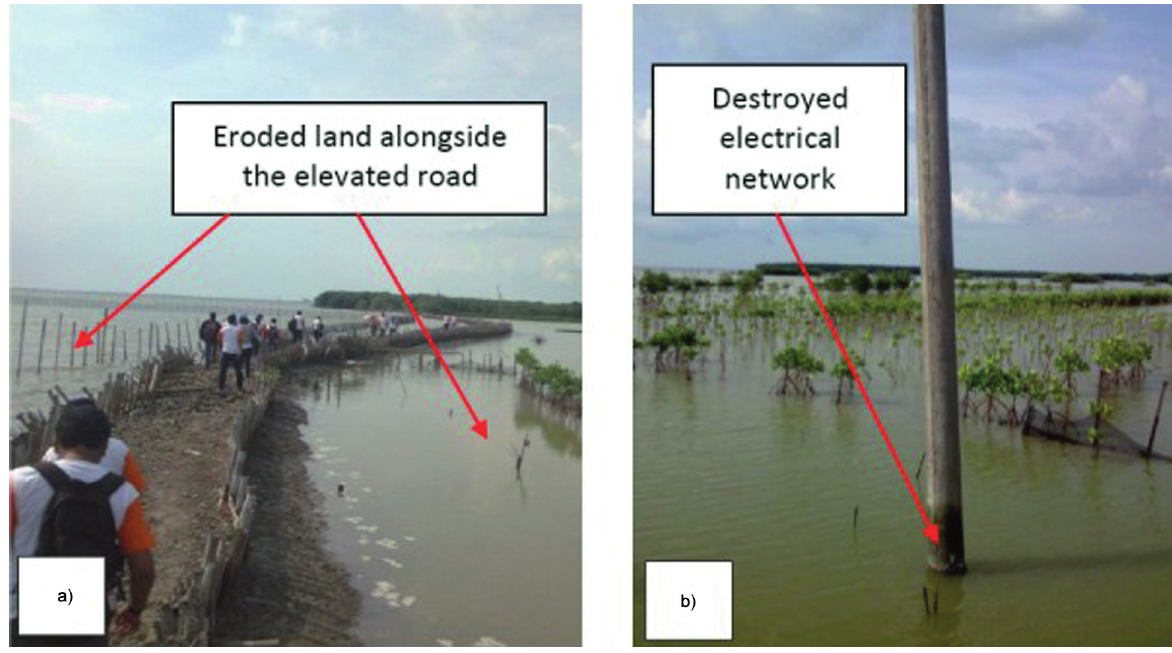
Fig. 4. The impact of coastal erosion to the land use. (a) damaged land around the elevated road due to coastal erosion. (b) destroyed electrical